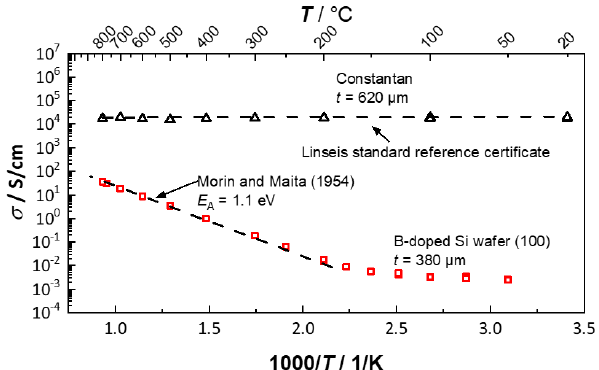
Figure 11. Arrhenius-like representation of the electrical conduc- tivity of constantan (thickness: 620µm) and a boron-doped Si wafer (thickness: 380µm) up to 800 ◦ C. Both measurements agree well with the